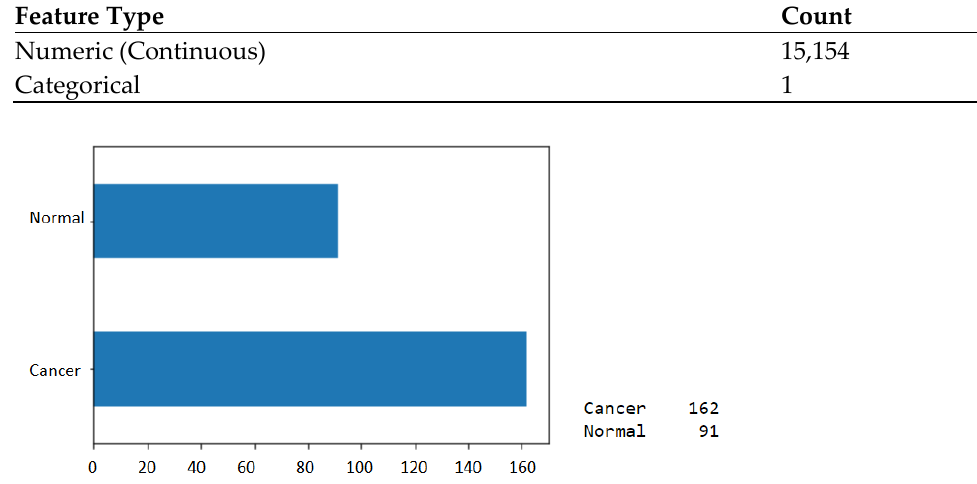
Figure 1. Distribution of current observations in the Ovarian